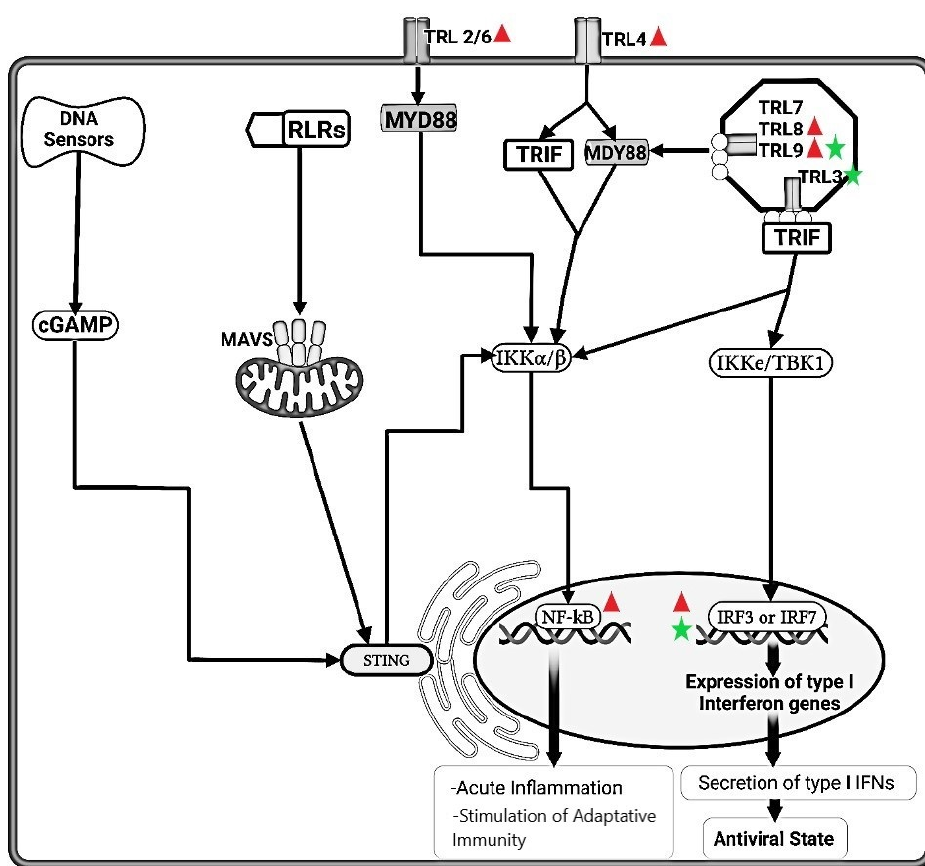
Figure 1. Schematic representation of signaling pathways and functions of Toll-like receptors (TLRs). TLRs 2 and 6 use the adaptor protein MyD88 and activate the transcription factor NF- κ B, which induces inflammatory gene expression. TLR3 uses the adaptor protein TRIF, which activates the IRF3 transcription factor and NF- κ B. TLR4 uses both MyD88 and TRIF, leading to activation of NF- κ B and IRF3 pathways, respectively. TLRs 7, 8, and 9 in the endosome use MyD88, leading to activation of both NF- κ B and IRF7, promoting expression of genes whose products mediate inflammation and antiviral defense. DNA viruses are sensed in the cytosol by the presence of the DNA sensors, the cGAS-STING pathway, resulting in the activation of NF- κ B and IRFs. RIG-I-like receptors (RLRs), recognize microbial nucleic acids and initiate the MAVs-STING pathways. The pathway targeted by feline coronavirus/feline peritonis virus (FeCoV/FIPV) and feline herpesvirus-1 (FeHV-1) are highlighted using and , respectively. FeCoV infection induced higher gene expression level of TLRs 2, 4, 8 and 9, but not TLRs 3 and 7, suggesting either lack of an appropriate trigger, or virus inhibition of TLR trascripion. The synthesis of accessory proteins 7a and 3 by FeCoV are probably involved in the inhibition of type I IFN synthesis. The FIPV nsp5 produced an inhibition of IRF3 phosphorylation and suppression of type I IFN production. FeHV-1 infection induced an upregulation of TRL9 expression and a downregulation of TLR3.The FeHV-1 US3 protein competitively binds to IRF binding domain hindering dimerization of IRF3. TIR , Toll IL-1 receptor; TLR , Toll-like receptors; MyD88 , Myeloid differentiation primary response 88; TRIF , TIR-domain-containing adapter-inducing interferon- β ; NF- κ B , Nuclear Factor kappa B; IRFs , Interferon Regulatory Factors; IFN , Interferon; IKK , Inhibitor-KbKinase; TBK1 , TANK Binding Kinase 1; cGAMP , Cyclic guanosine monophosphate-adenosine monophosphate; STING , Stimulator of Interferon Genes; RLRs , RIG-I-like receptors; MAVs , Mitochondrial antiviral-signaling protein; nsp , nonstructural protein.